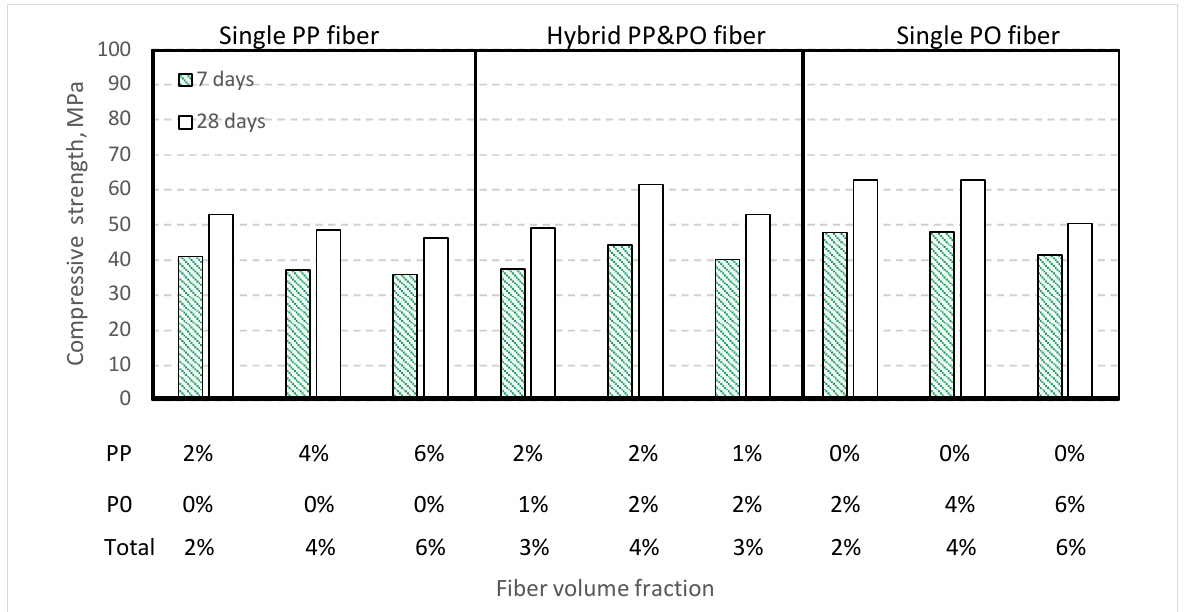
Figure 13. Effect of lightweight fiber hybridization on 7 and 28-day concrete compressive strength.